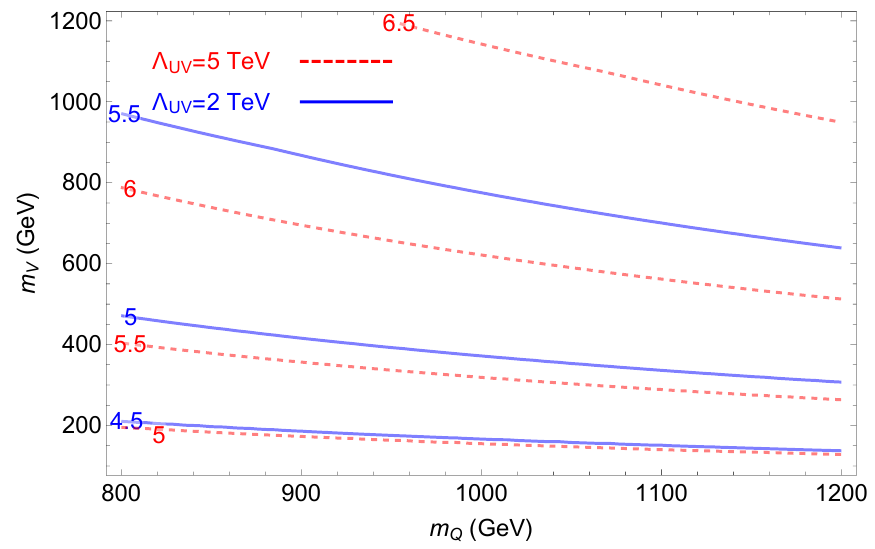
Figure 4 . Contours of the hidden color (cid:3) QCD as a function of the vector-like masses of hidden color fermions. The blue solid (red dashed) contours correspond to a UV cuto(cid:11) (cid:3) UV = 2(5) TeV b where the SM and hidden strong couplings become